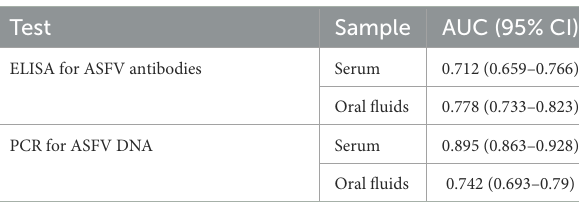
TABLE 6 AUC and associated 95% confidence intervals for each test-sample